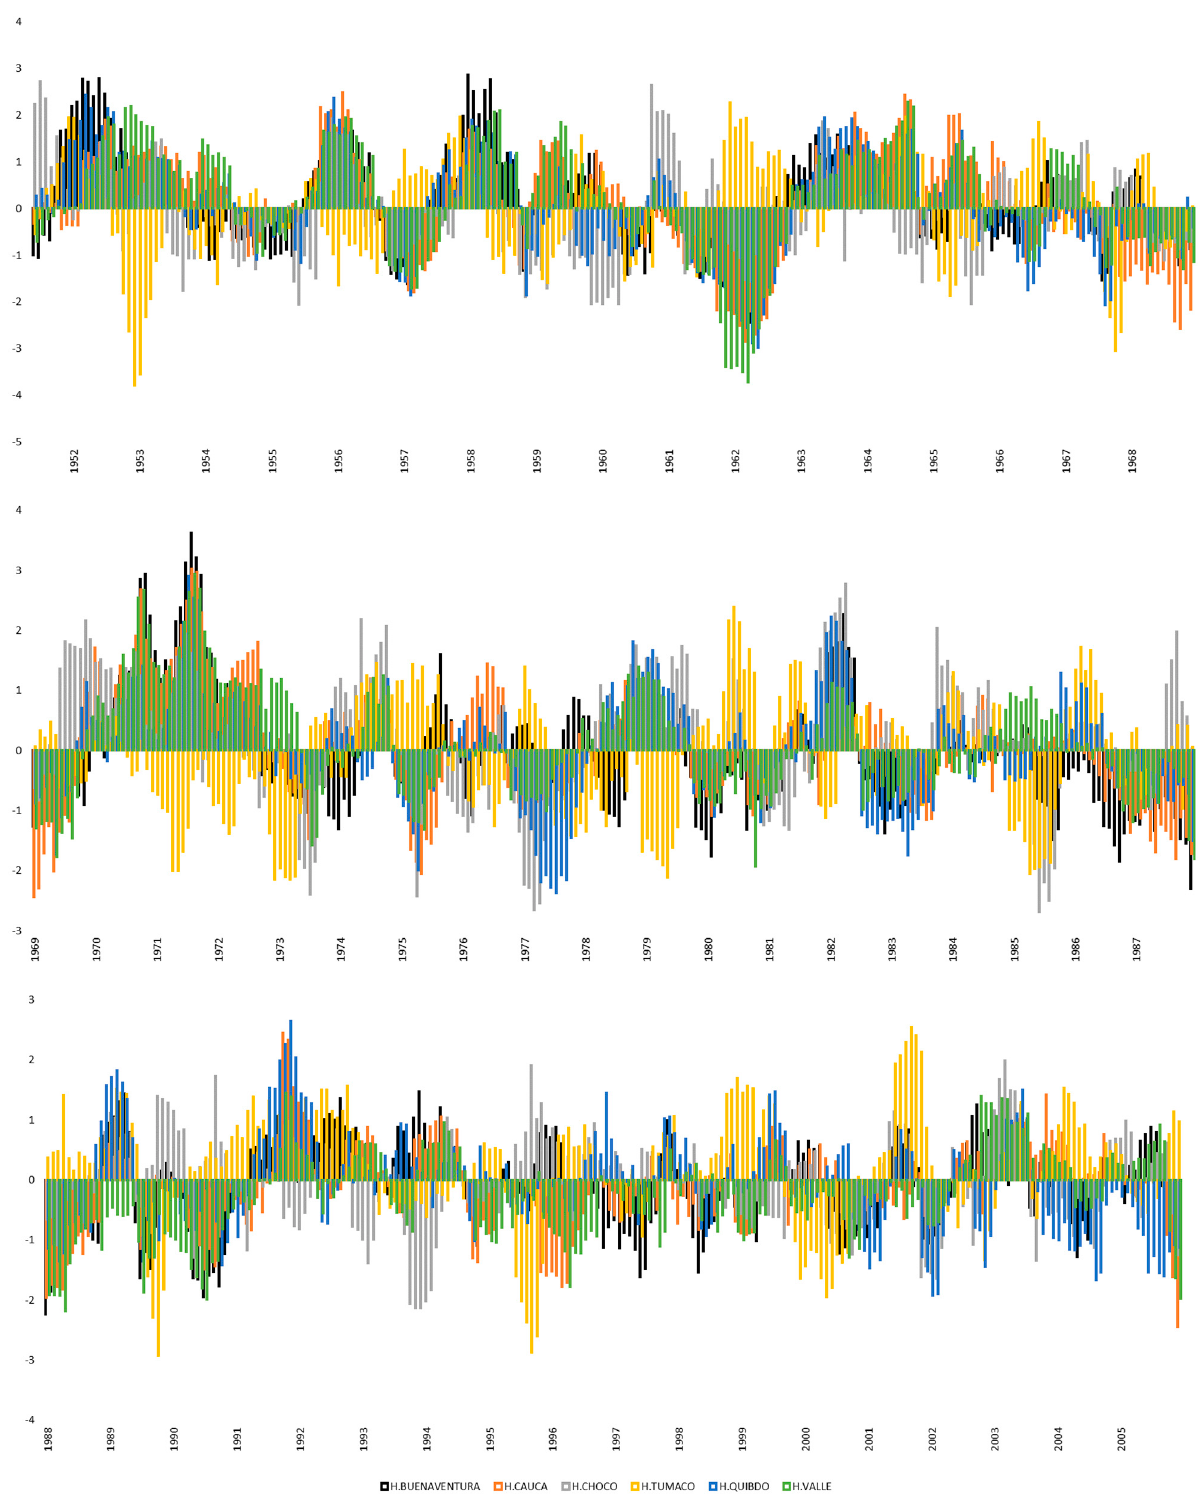
Figure 3. Six − month standardized precipitation index in Colombia’s Pacific region, 1951–2005. A 12-month SPI (SPI 12) compares the precipitation that fell over a period of 12 months to the precipitation that fell over the same length of time in the preceding years (for which data are available). Unless there is a strong wet or dry trend, SPI 12 tends to lean toward zero because intervals with above- and below-normal precipitation tend to be balanced over a 12-month